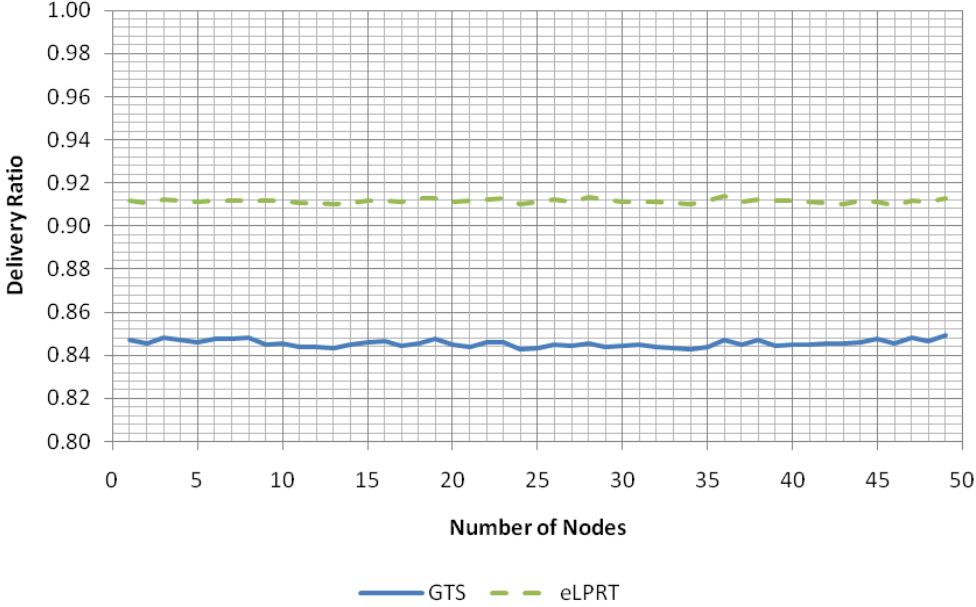
Figure 6. Delivery ratio of eLPRT and GTS, with BER